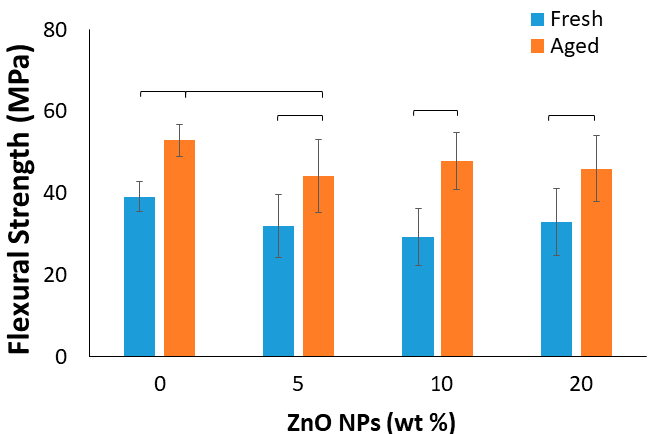
Figure 4. The flexural strength of the methacrylate-based resin blends. Horizontal bars indicate a significant difference ( p < 0.05; n = 12).